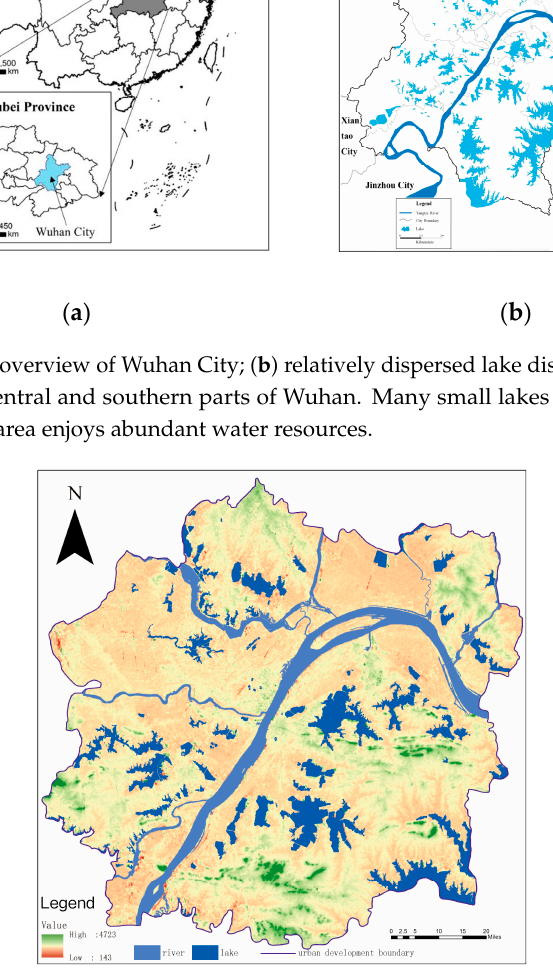
Figure 2. Scope of Wuhan urban development area. Table 1. Main lakes in the study area (key protected lakes within the scope defined by Wuhan Lake Protection Regulations [26]).